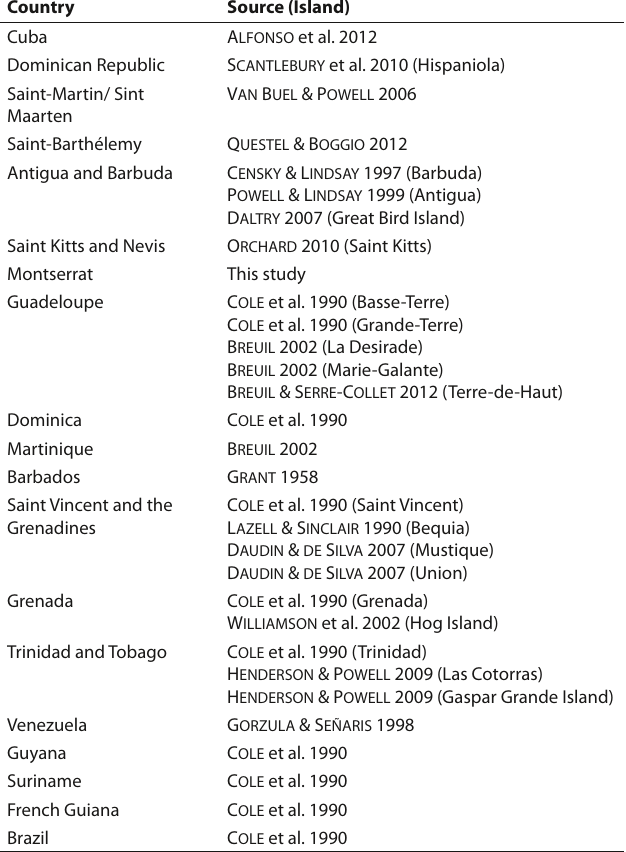
Table 1. Countries where Gymnophthalmus underwoodi has been docu- mented. Records from C ole et al. 1990 represent museum specimens. Specific islands are noted where information is available.